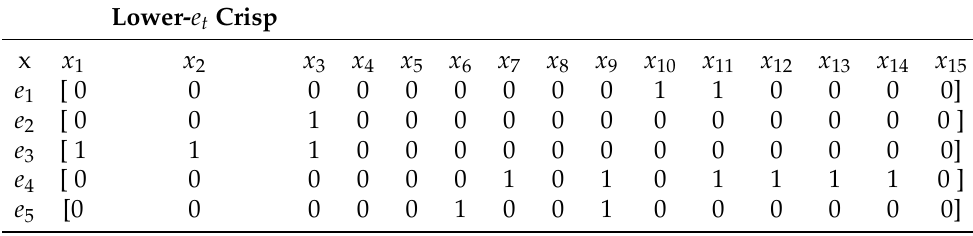
Table 8. β -Lower- e t ; t = 1, . . . ,5.